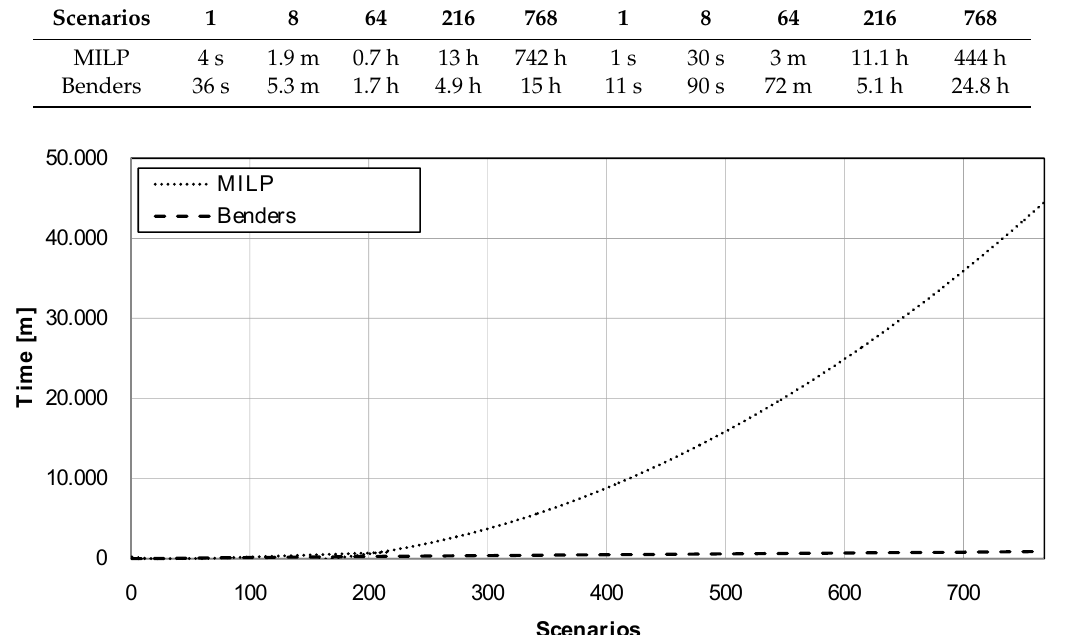
Figure 3. CPU time for Case a.